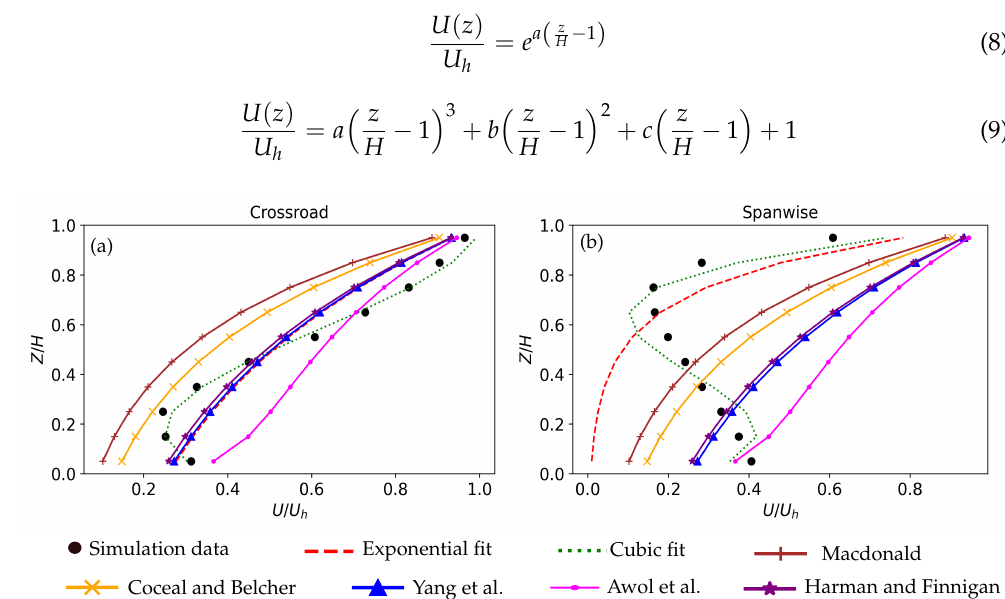
Figure 10. Comparison of legacy schemes (Macdonald [6], Coceal and Belcher [7], Harman and Finnigan [8], Yang et al. [10], Awol et al. [13]) and curve fitting equations for case 13 in the crossroad ( a ) and spanwise ( b )